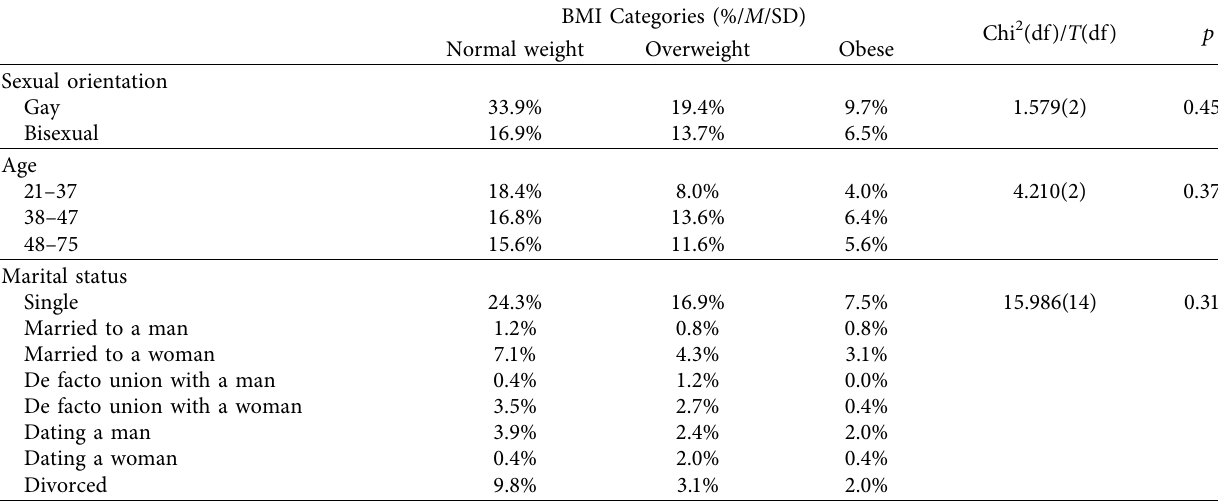
Table 2: Results for multiple variables by BMI categories.